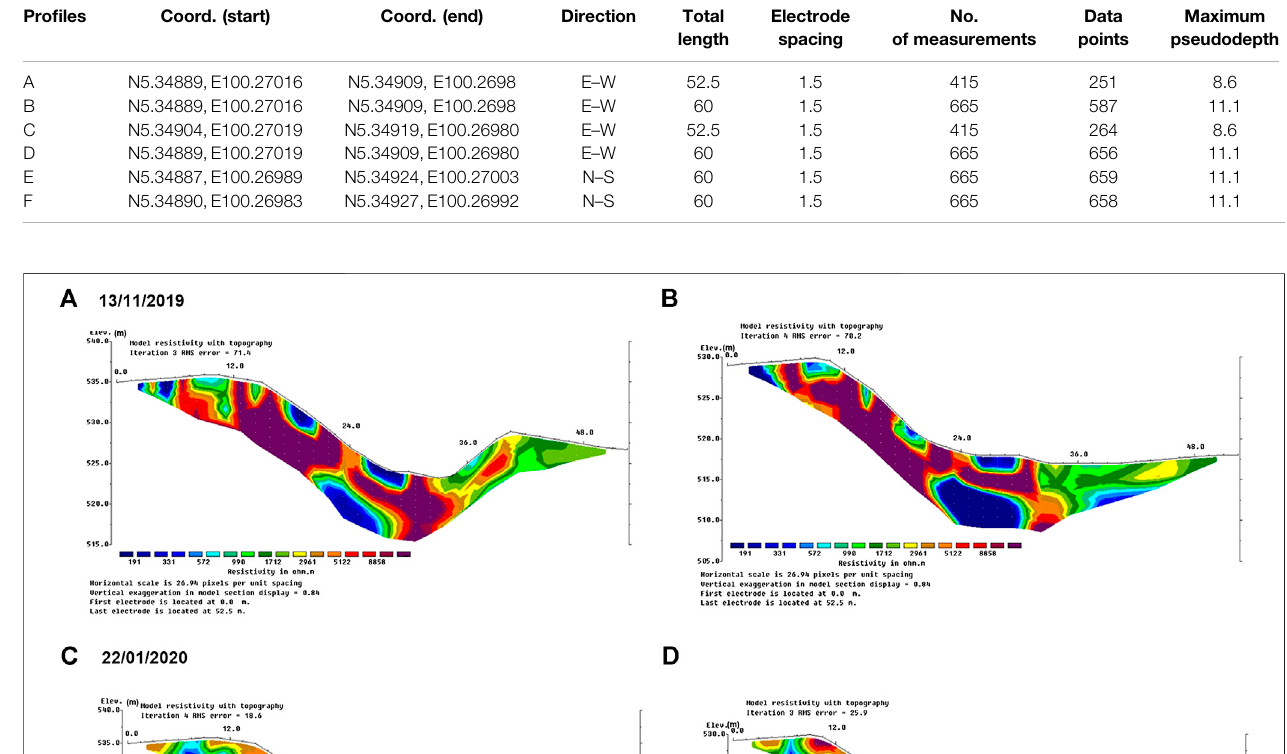
Frontiers in Earth Science |